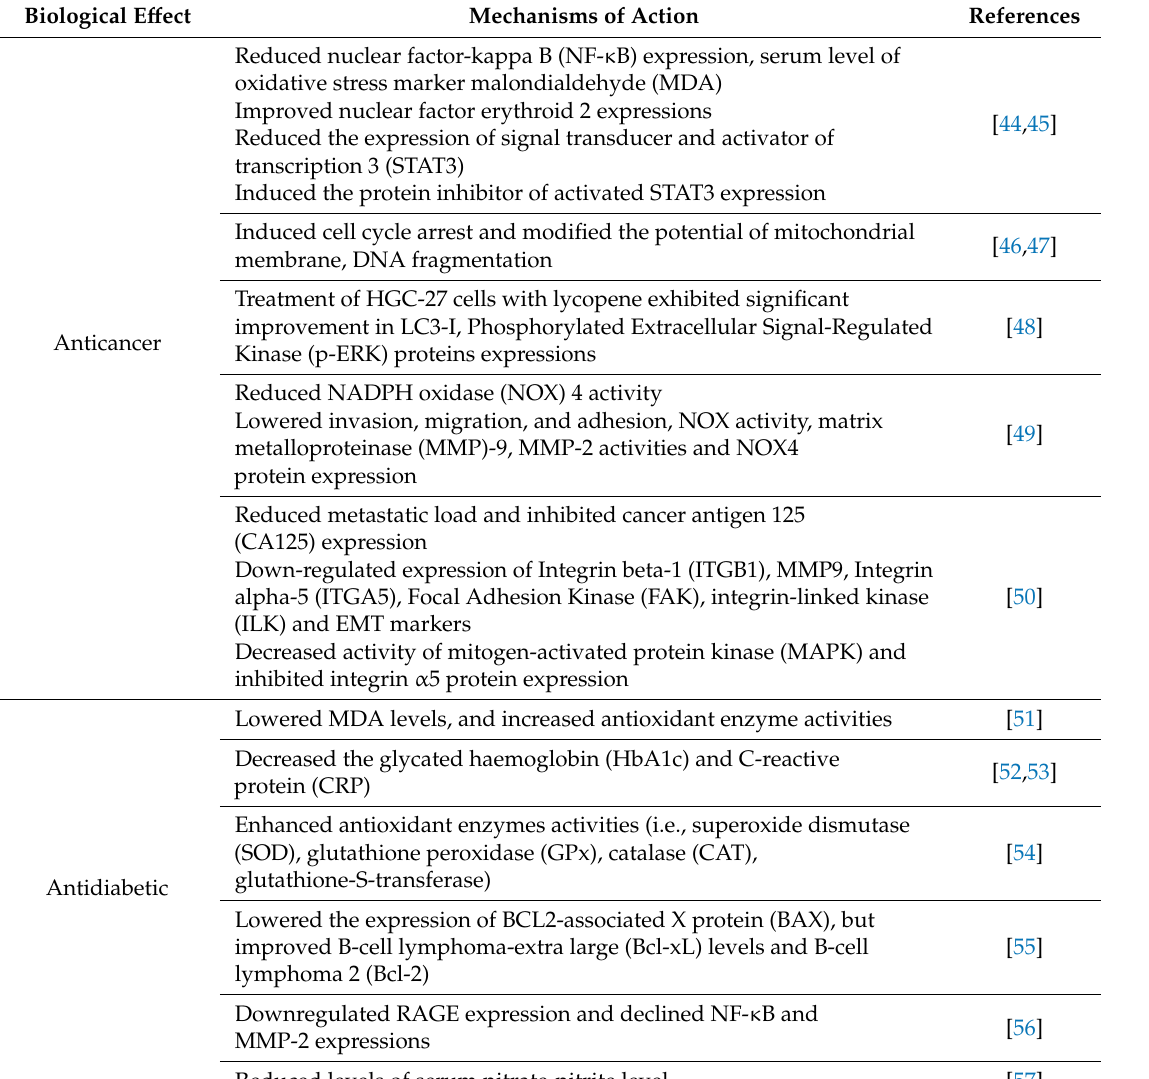
Table 2. Various mechanisms for lycopene’s biological e ff